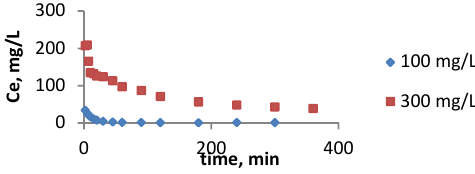
Fig.6. Effect of time on adsorption of MB on AC prepared by microwave